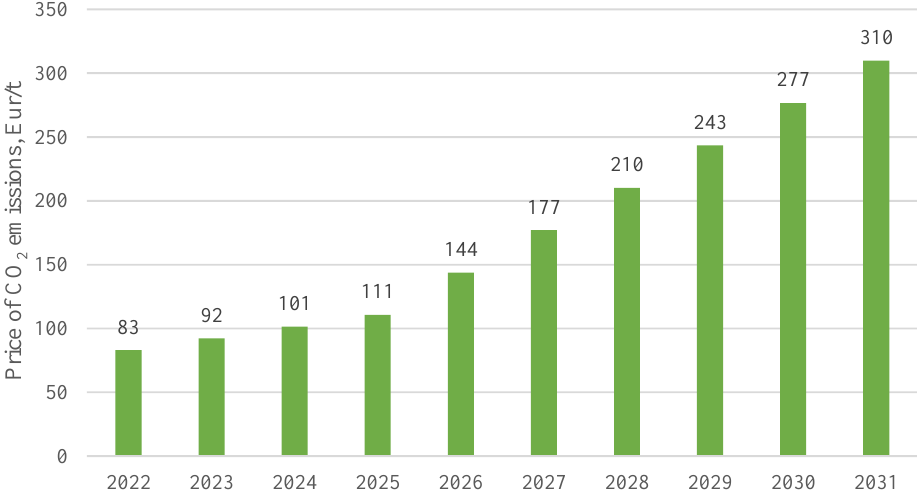
Figure 7. Forecasted trend of CO 2 emission prices in Lithuania for the period of 2022–2031.